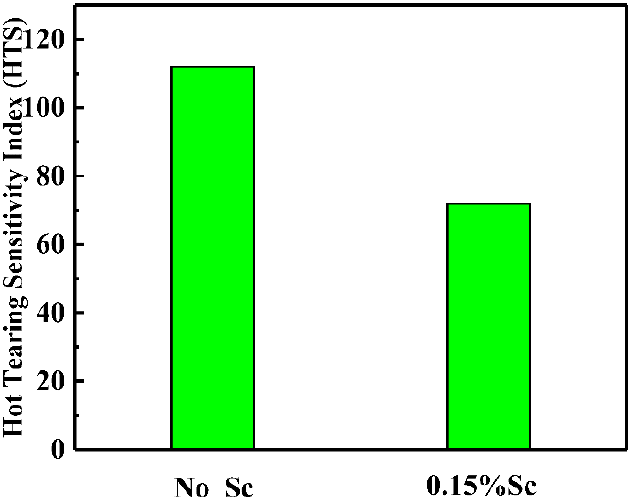
Figure 6. Alloy hot tearing sensitivity value with or without the addition of Sc treatment.